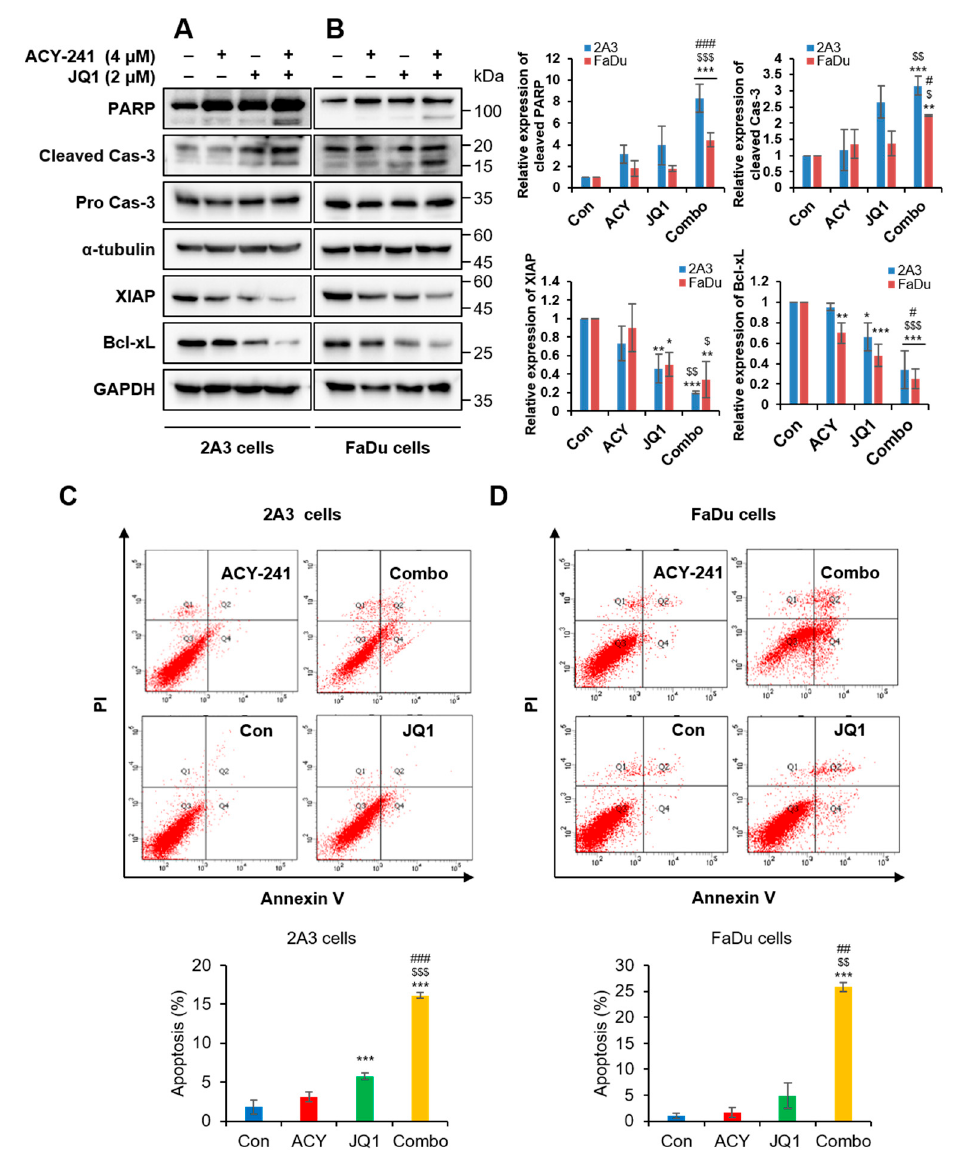
Figure 3. Combination treatment of ACY-241 and JQ1 synergistically induces apoptosis in HNSCC. ( A , B ) Immunoblot analysis of pro-apoptotic proteins (PARP, Cas-3) and anti-apoptotic proteins (XIAP, Bcl-xL) in 2A3 and FaDu cells. α -tubulin and GAPDH were used as loading controls. Protein levels were quantified relative to the loading control. Total protein was extracted after 24 h of ACY-241 (4 µ M) or JQ1 (2 µ M) treatment alone or in combination. ( C , D ) Flow cytometry analysis of 2A3 and FaDu cells. Cells were treated with 0.2% DMSO, ACY-241 (4 µ M), or JQ1 (2 µ M) alone or in combination for 72 h. 2A3 and FaDu cells were stained with annexin V and PI for 15 min. Values represent mean ± SD ( n = 3). * p < 0.05, ** p < 0.01, or *** p < 0.001 vs. DMSO control, $ p < 0.05, $$ p < 0.01, or $$$ p < 0.001 vs. ACY-241-treated group, # p < 0.05, ## p < 0.01, or ### p < 0.001 vs. JQ1-treated group.